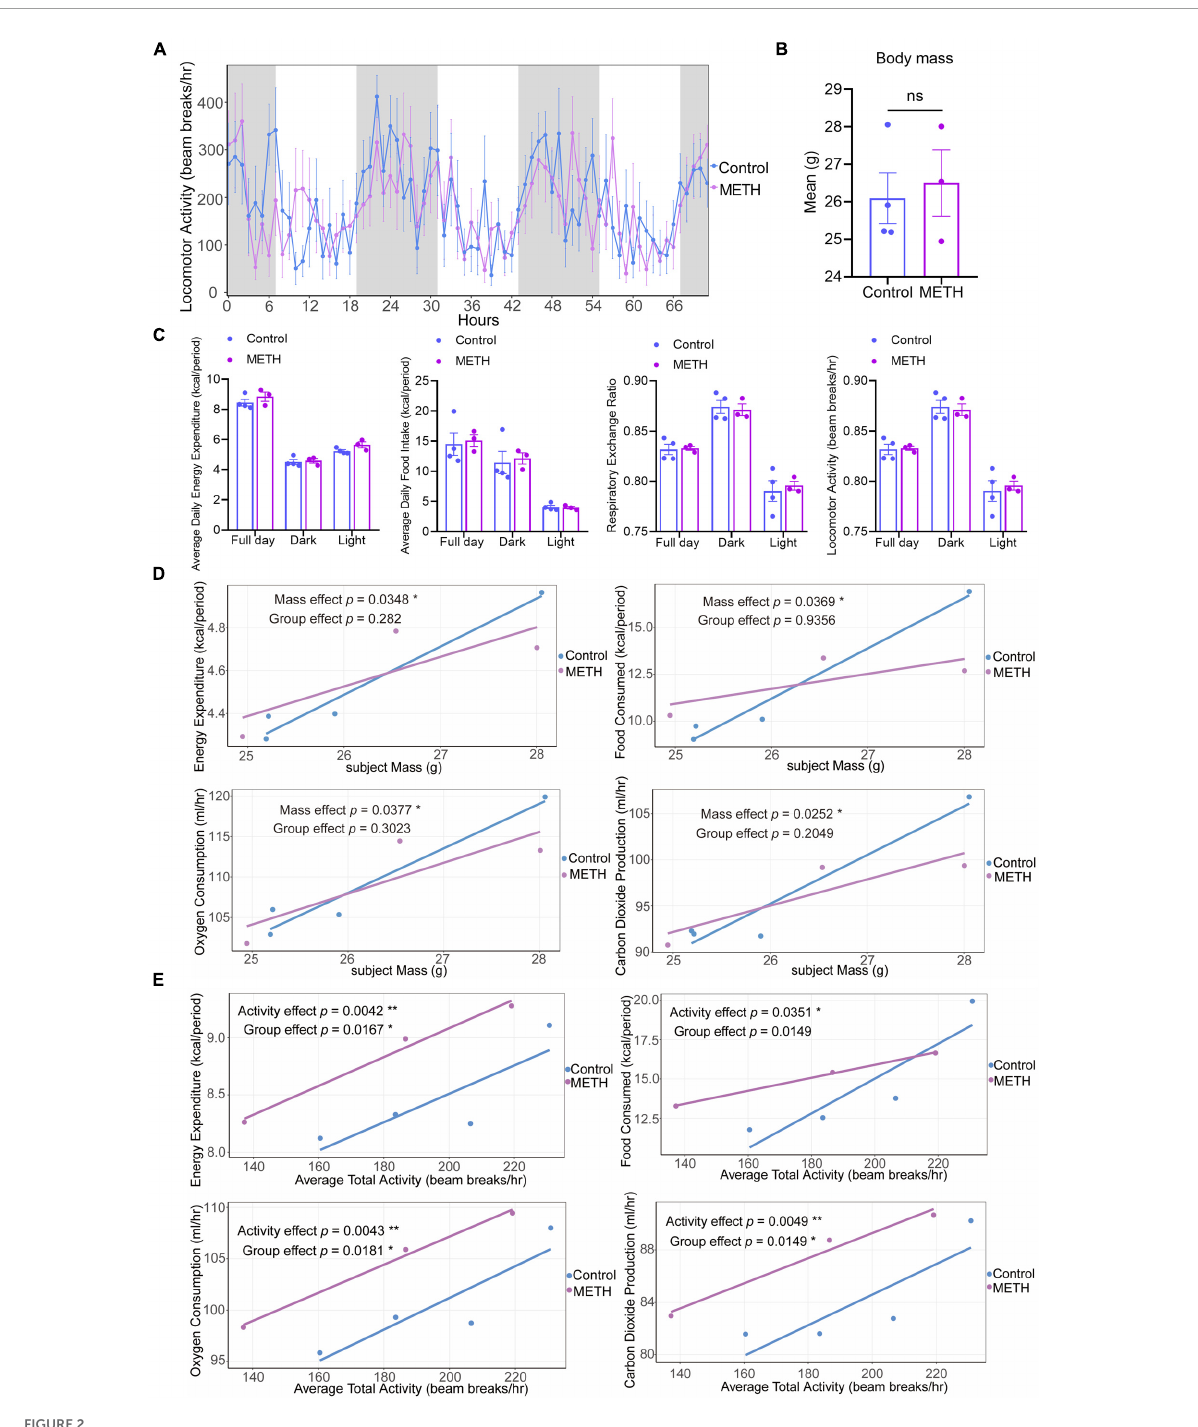
FIGURE2 Methamphetamine (METH) exposure resulted in an imbalance of energy metabolism in mice. (A) The circadian locomotor activity in a metabolic cage of mice in the METH group and control group within 3 days. The gray shadows represent the dark (start at 19:00), and white represents the light (start at 7:00). (B) The average body mass of mice in the two groups before and after the metabolic cage test. (C) Changes in metabolic parameters (average daily energy expenditure, average daily food intake, respiratory exchange ratio, and locomotor activity) in the METH group ( n = 3) and control group ( n = 4). (D) GLM-based regression plots in which the average of the selected metabolic variables is plotted against body mass. (E) GLM-based regression plots in which the average of the selected metabolic variables is plotted against the average total activity. The data in (B,C) were compared with an unpaired t test and are expressed as the mean ± SEM. The generalized linear model was used to analyze the effects of body mass and activity on metabolic variables in mice of the METH group and control group. Significance is shown as * p < 0.05, ** p < 0.01, *** p < 0.001, and **** p <